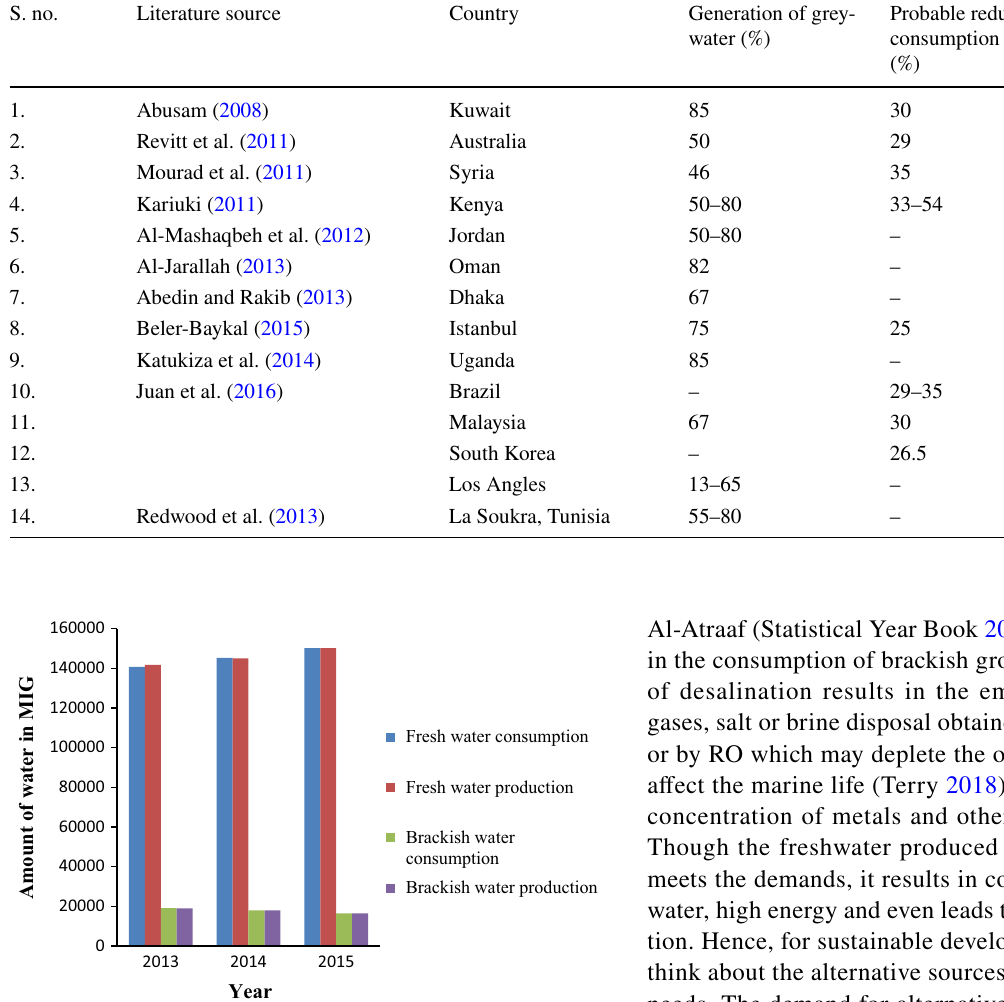
Table 1 Percentage of greywater generation and probable reduction of domestic water in different countries S. no.